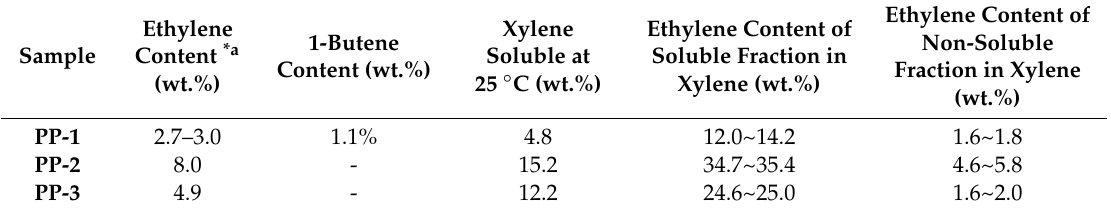
Table 3. Chemical composition of the pilot pellets and xylene soluble fraction at 25 ◦